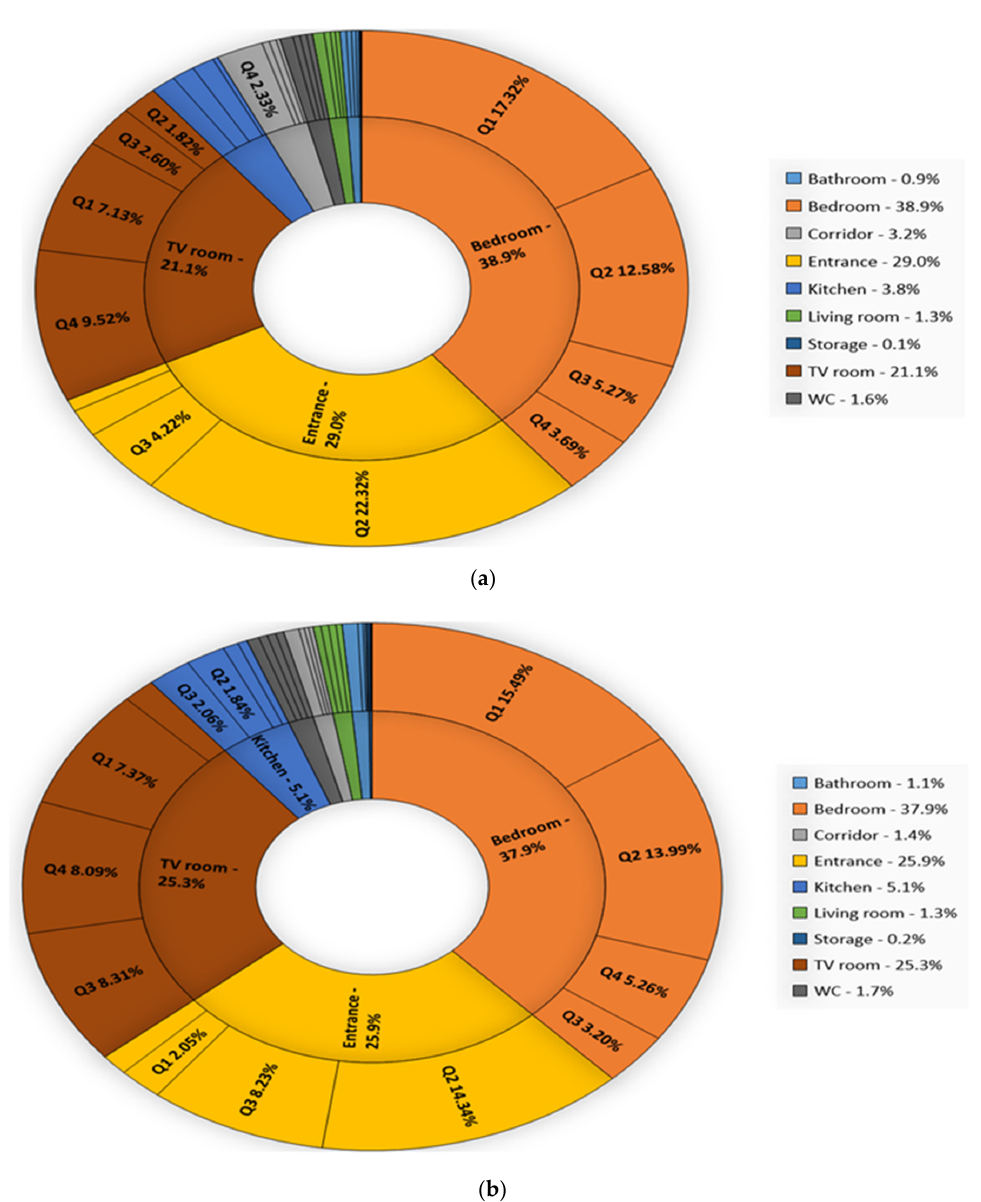
Figure 17. The average time duration in each location in a day and in different quarters of a day for ( a ) weekdays ( b ) and weekends in re-deployment dataset. ( a ) weekdays ( b ) and weekends in re-deployment